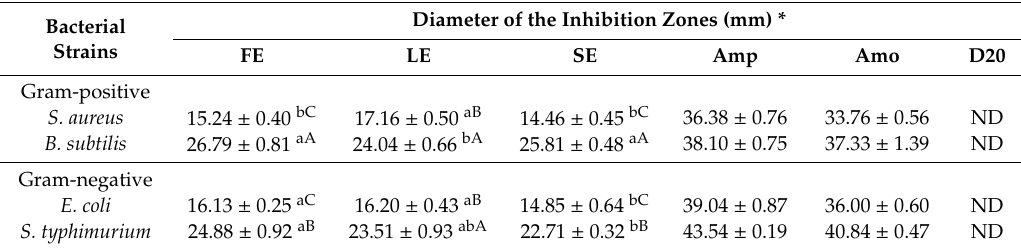
Table 5. Antibacterial activity of edible and non-edible parts of broccoli. Bacterial